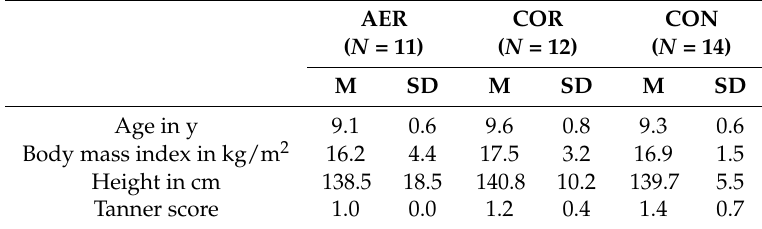
Table 1. Participants’ characteristics.